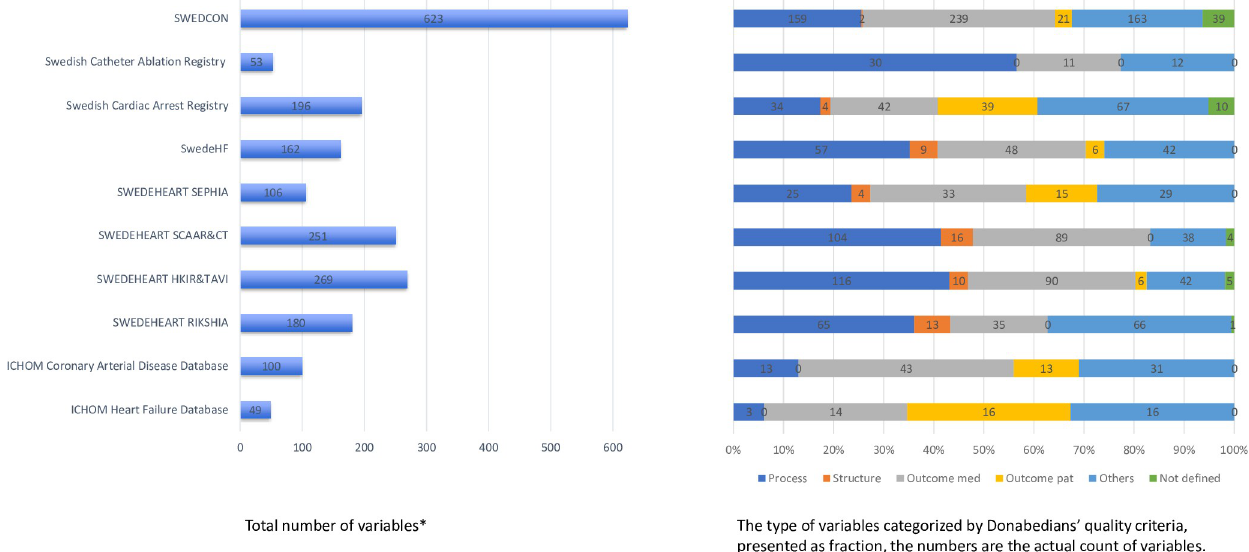
Fig 1. Overview of the total number of variables and the distribution (proportion in percentage) of the type of variables classified according to Donabedian’s quality criteria ( process , structures and outcomes ) in the Swedish National Quality Registries and the International Consortium of Health Outcomes Measurement (ICHOM) standard sets. SWEDEHEART = Swedish Websystem for Enhancement and Development of Evidence-based care in heart disease; RiksHIA = acute coronary care; SEPHIA = secondary prevention; HKIR & TAVI = heart surgery; SCAAR & CT = Coronary angiography and percutaneous coronary intervention; SWEDCON = Swedish Registry of Congenital Heart Disease; SwedeHF = Swedish Heart Failure Registry (available at www.kvalitetsregister.se). Outcomes were differentiated between information that were clinician-reported or patient-reported.”Others” were variables were administrative information like patient’s address, time point assessed or information regarding patient characteristics like patient’s age. There were some variables in the NQRs that had a variable code but no definition; these variables were categorized as “not defined”.